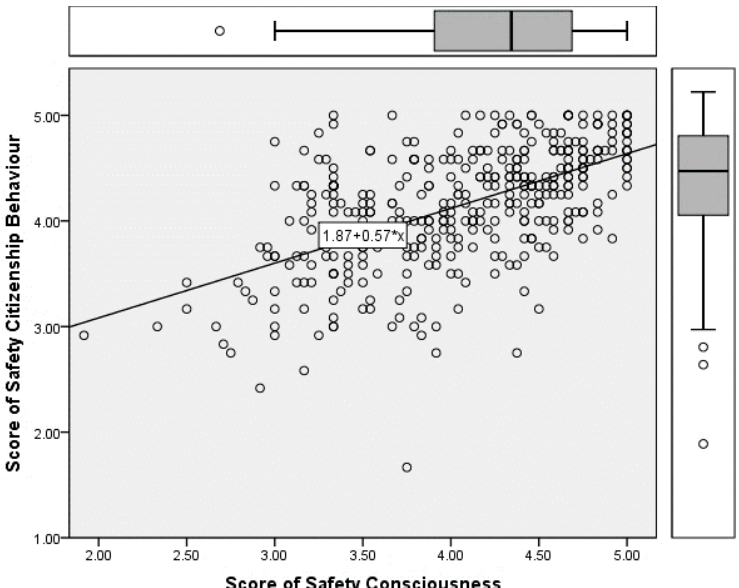
Figure 2. Single linear model for Safety Citizenship Behaviour and Safety Consciousness. The R 2 value was 0.663, which confirmed the significant linear correlation between the variables.